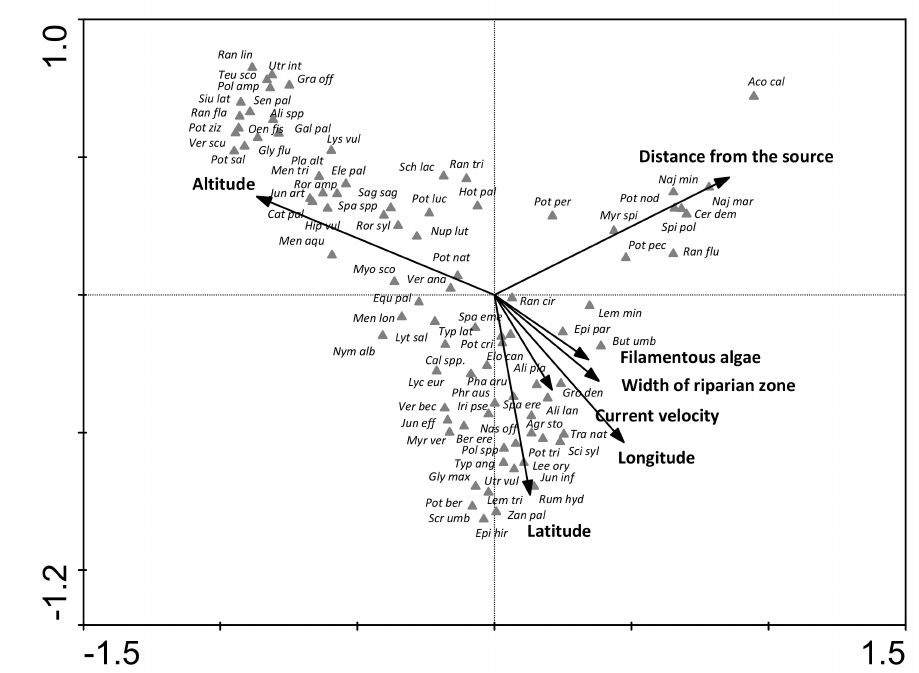
Figure 4. CCA plot showing the relationships between species presence and abundance, and significant environmental parameters detected in different stretches of the examined rivers. Only the parameters explaining at least 0.95% of the variability of species presence and abundance are presented. Abbreviated species names: Acorus calamus (Aco cal) , Agrostis stolonifera agg. ( Agr sto ), Alisma lanceolatum ( Ali lan ), Alisma plantago-aquatica ( Ali pla ), Alisma spp. ( Ali spp ), Berula erecta ( Ber ere ), Butomus umbellatus ( But umb ), Callitriche spp. ( Cal spp. ), Caltha palustris ( Cat pal ) , Ceratophyllum demersum ( Cer dem ) , Eleocharis palustris ( Ele pal ), Elodea canadensis ( Elo can ), Epilobium hirsutum ( Epi hir ), Epilobium parviflorum (Epi par ), Equisetum palustris (Equ pal ), Galium palustre (Gal pal ), Glyceria fluitans (Gly flu ), Glyceria maxima (Gly max ), Gratiola officinalis (Gra off ), Groenlandia densa (Gro den ), Hippuris vulgaris (Hip vul ), Hottonia palustris (Hot pal ), Iris pseudacorus (Iri pse ), Juncus articulatus ( Jun art ), Juncus effusus ( Jun eff ), Juncus inflexus ( Jun inf ), Leersia oryzoides ( Lee ory ), Lemna minor ( Lem min ), Lemna trisulca ( Lem tri ), Lycopus europaeus ( Lyc eur ), Lysimachia vulgaris ( Lys vul ), Lythrum salicaria ( Lyt sal ), Mentha aquatica ( Men aqu ), Mentha longifolia ( Men lon ), Menyanthes trifoliata ( Men tri ), Myosotis scorpioides agg. ( Myo sco ), Myriophyllum spicatum ( Myr spi ), Myriophyllum verticillatum ( Myr ver ), Najas marina ( Naj mar ), Najas minor ( Naj min ), Nasturtium officinale ( Nas off ), Nuphar luteum ( Nup lut ), Nymphaea alba ( Nym alb ), Oenanthe fistulosa ( Oen fis ), Phalaris arundinacea ( Pha aru ), Phragmites australis ( Phr aus ), Plantago altissima ( Pla alt ), Polygonum amphibium ( Pol amp ), Polygonum spp. ( Pol spp ), Potamogeton berchtoldii ( Pot ber ), Potamogeton crispus ( Pot cri ), Potamogeton lucens ( Pot luc ) , Potamogeton natans ( Pot nat ), Potamogeton nodosus ( Pot nod ), Potamogeton pectinatus ( Pot pec ), Potamogeton perfoliatus ( Pot per ), Potamogeton salicifolius ( Pot sal ), Potamogeton trichoplyllus ( Pot tri ), Potamogeton x zizii ( Pot ziz ), Ranunculus circinatus ( Ran cir ), Ranunculus flammula ( Ran fla ), Ranunculus fluitans ( Ran flu ), Ranunculus lingua ( Ran lin ), Ranunculus trichophyllus ( Ran tri ), Rorippa sylvatica ( Ror amp ), Rorippa amphibia ( Ror syl ), Rumex hydrolapathum ( Rum hyd ), Sagittaria sagittifolia ( Sag sag ), Schoenoplectus lacustris ( Sch lac ), Scirpus sylvaticus ( Sci syl ), Scrophularia umbrosa ( Scr umb ), Senecio paludosus ( Sen pal ), Sium latifolium ( Siu lat ), Sparganium emersum ( Spa eme ), Sparganium erectum agg. ( Spa ere ), Sparganium spp. ( Spa spp.), Spirodela polyrhiza ( Spi pol ), Teucrium scordium ( Teu sco ), Trapa natans ( Tra nat ), Typha angustifolia ( Typ ang ), Typha latifolia ( Typ lat ), Utricularia intermedia ( Utr int ), Utricularia vulgaris ( Utr vul ) , Veronica anagallis-aquatica ( Ver ana ), Veronica beccabunga ( Ver bec ), Veronica scutellata ( Ver scu ), Zannichellia palustris ( Zan pal